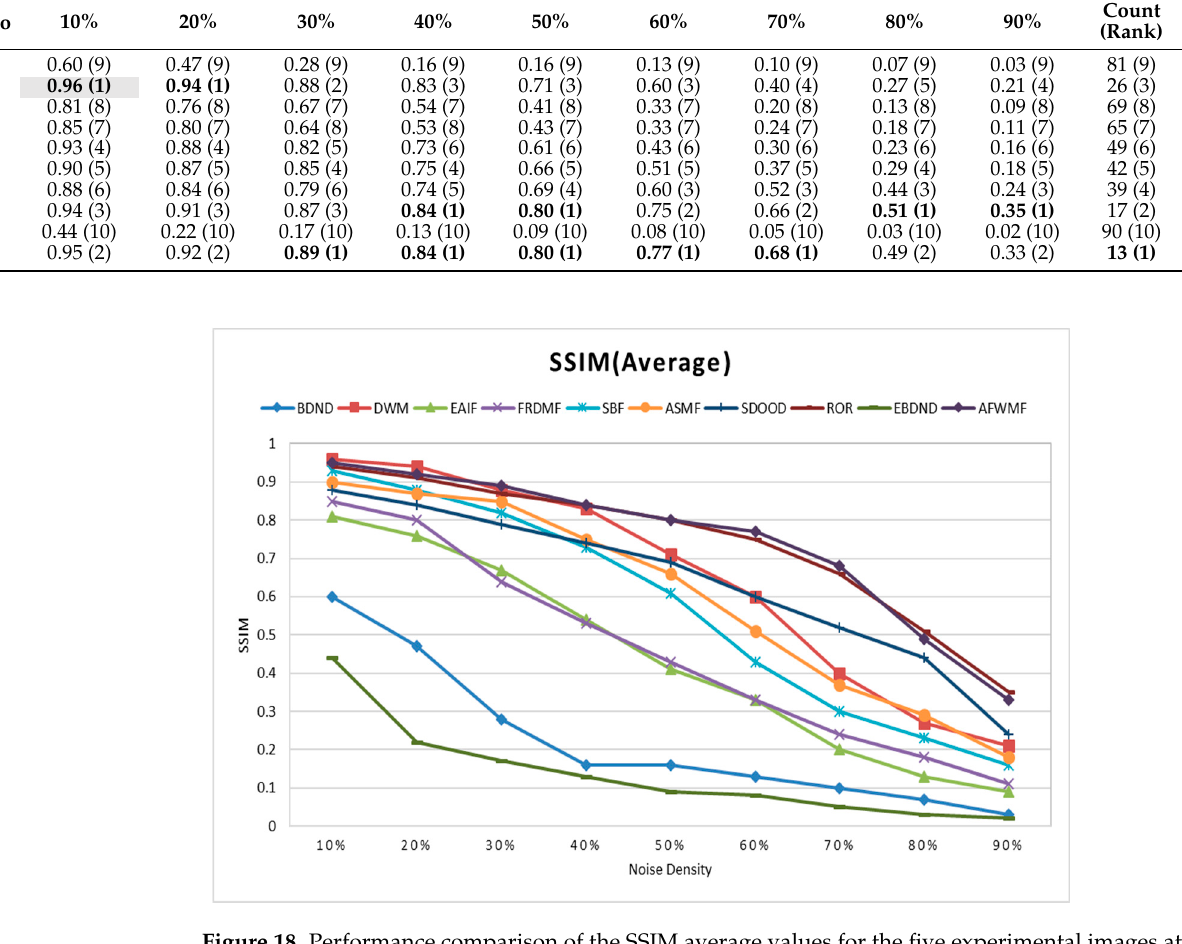
Figure 18. Performance comparison of the SSIM average values for the five experimental images at different random values of pulse noise